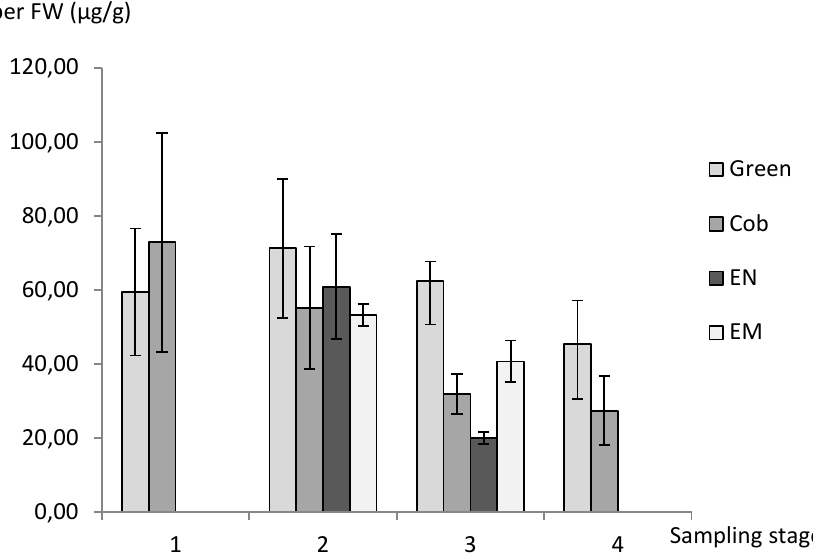
Fig. 2. DNA densities per fresh weigth (FW) of different plant parts at four sampling stages. EN = Endosperm, EM = Embryo. Vertical bars represent SD over 10 different plants (n =